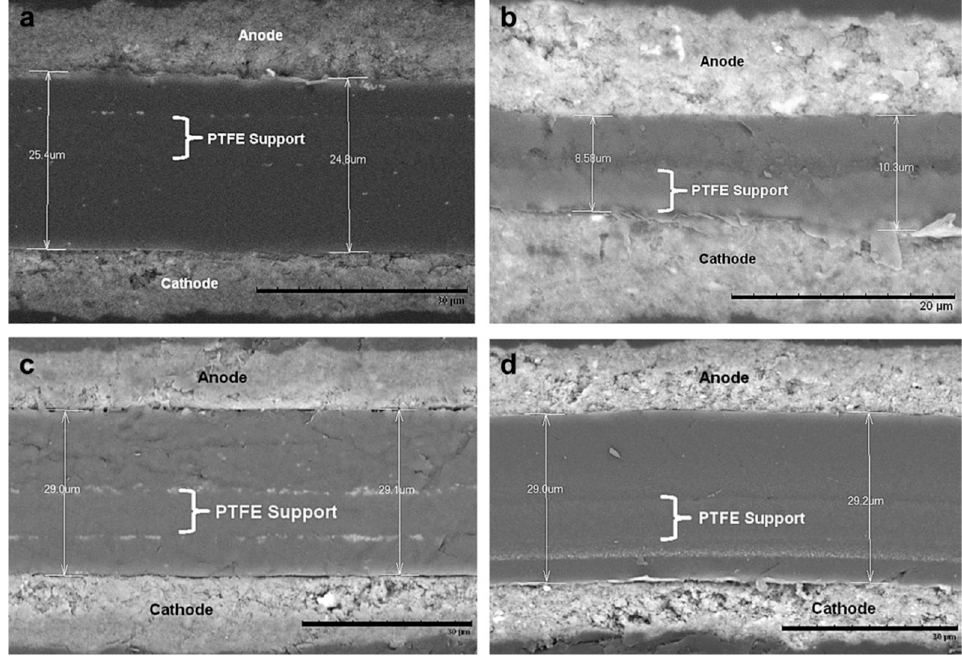
Figure 6. SEM images of CCM cross-sections: baseline ( a ) before and ( b ) after 500 h OCV hold test; commercial 1.0 wt. % ceria ( c ) before and ( d ) after 500 h OCV hold test [68].